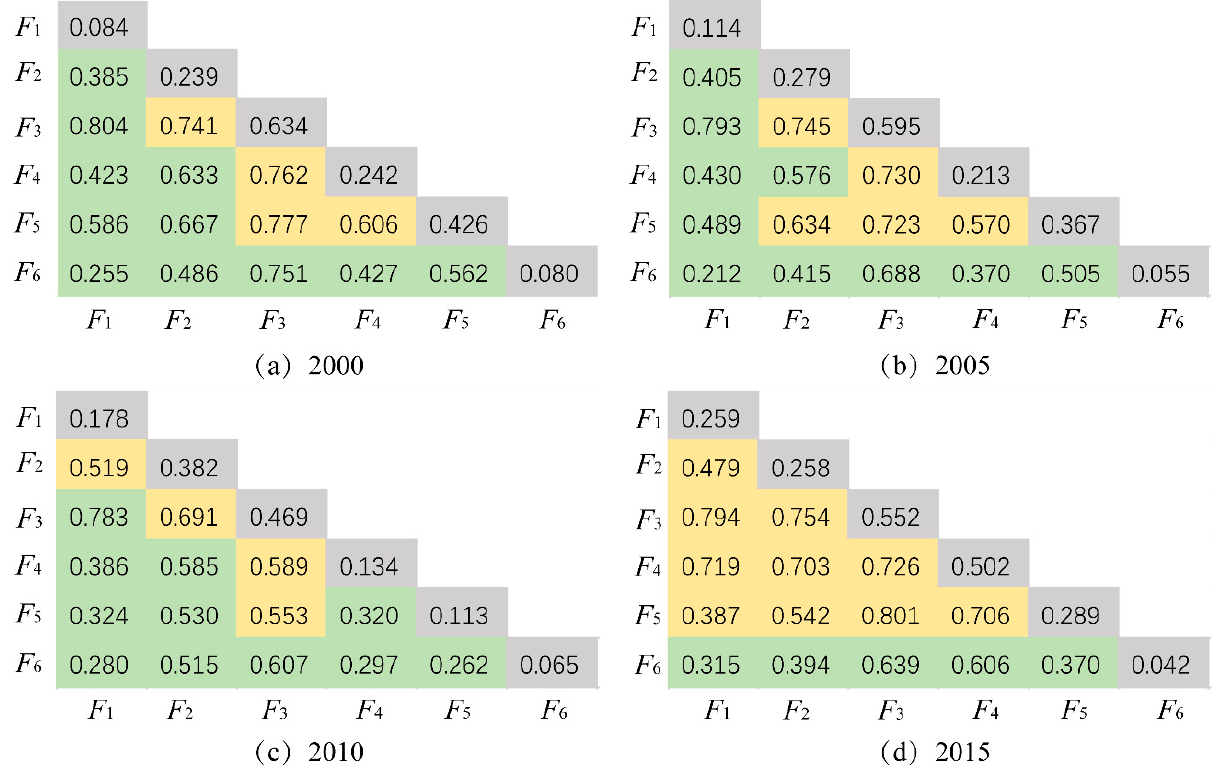
Figure 9. Interactive detection results in non-state-designated poverty counties in China from 2000 to 2015(from Fig.4(a) to Fig.4(d), respectively): Gray indicates single factor action, Orange indicates bivariate enhancement, and Green indicates nonlinear enhancement. The value of the q- statistic was significant at 5% level.